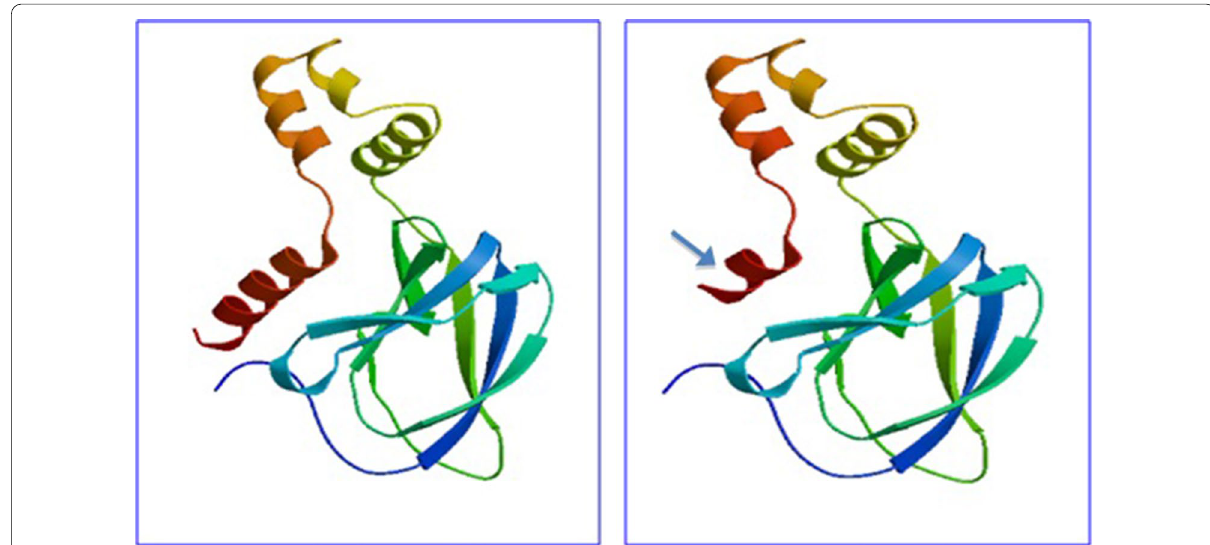
Fig. 1 Schematic view of the VHL-Wild type (left panel) and VHL-Mutated (right panel) homology model where VHL-Mutated shows truncated α helix (indicated by arrow)